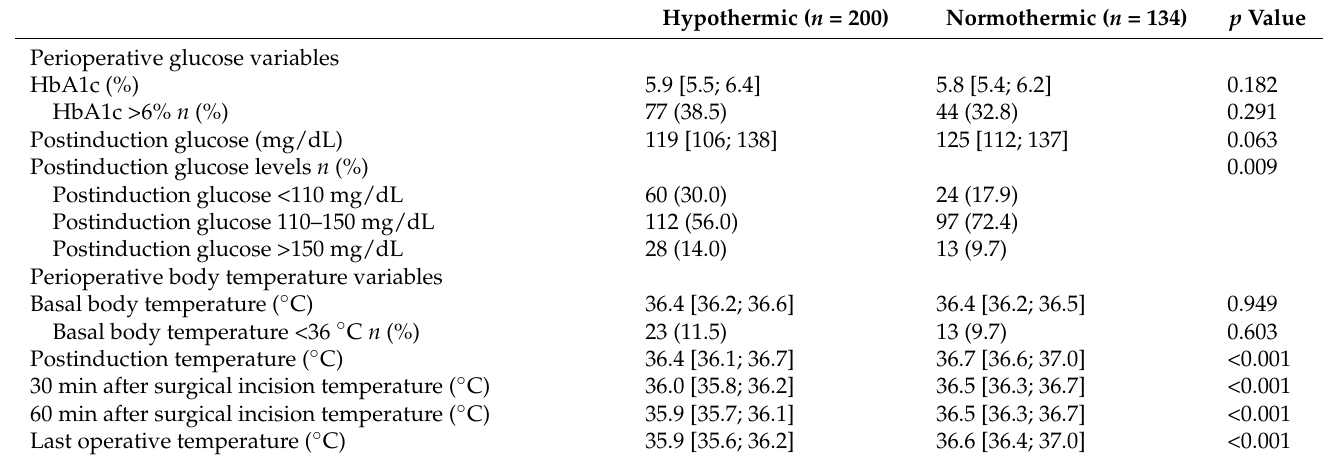
Table 2. Perioperative glucose and body temperature variables for hypothermic and normother- mic patients.